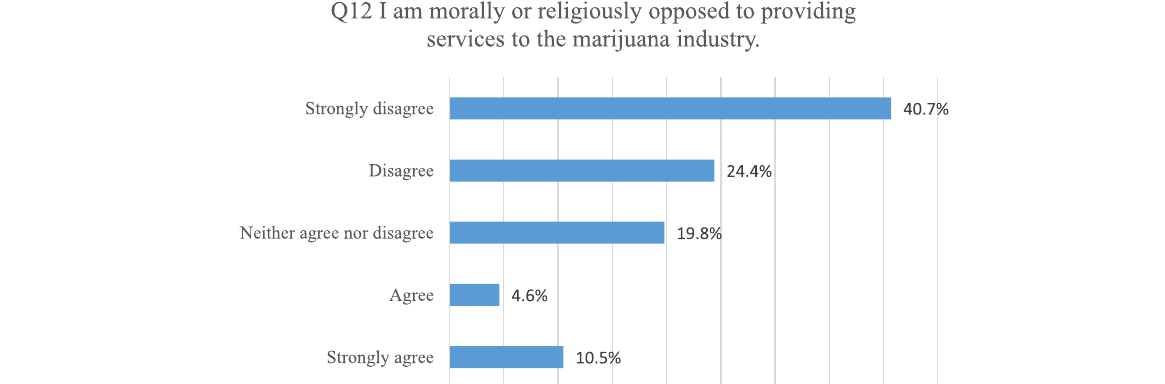
Fig. 9 Indication of CPAs’ agreement with the survey statement “I am morally or religiously opposed to providing services to the marijuana industry”